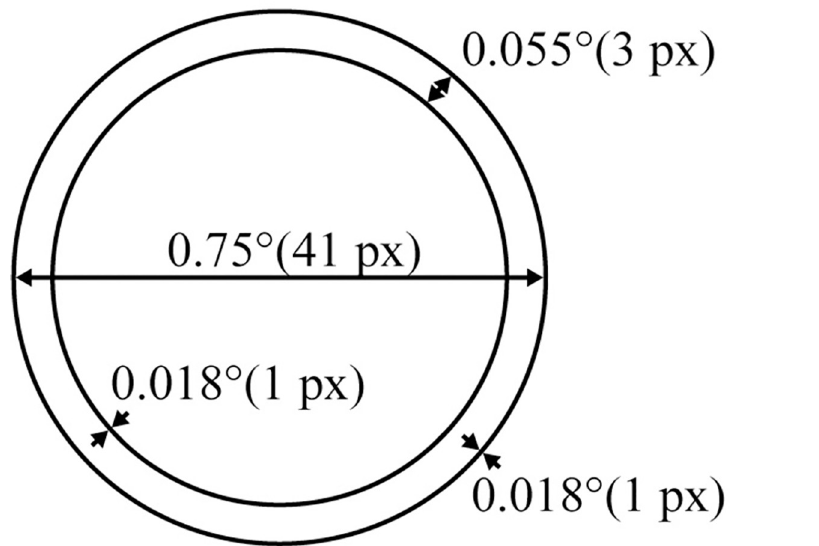
Fig 6. Monocular element in the form of a